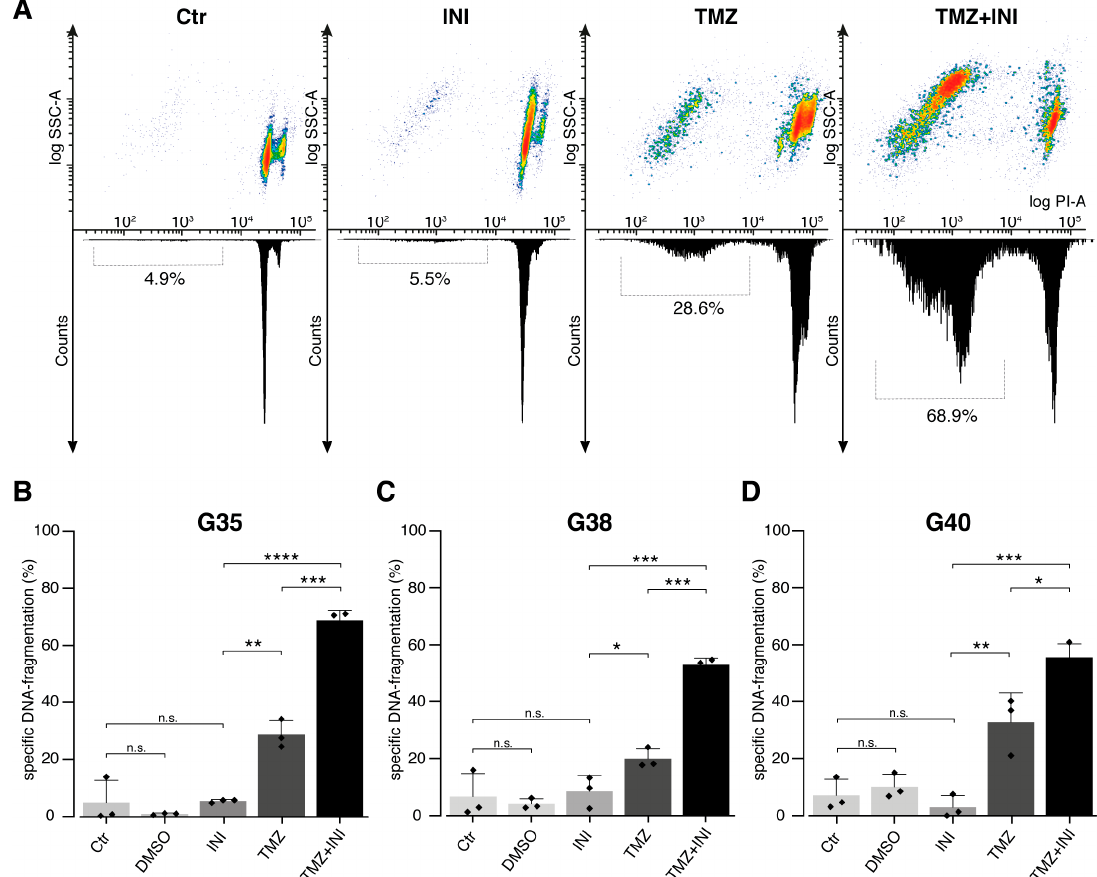
Figure 4. Gap junction-targeted therapy sensitizes glioblastoma cells to temozolomide-mediated cell death. ( A ) Effects on cell death: Treatment was performed with 50 µM TMZ, 100 µM INI, or combination of both. Percentage of DNA-fragmentation of propidium iodide-stained nuclei was determined by flow cytometric analysis 144 h after treatment. Representative density plots and histograms are shown for di ff erent treatment modalities for G35 cell population. The SubG1 peak is accentuated within the histograms and the mean percentage of DNA-fragmentation is depicted below. ( B ) Mean ± SD of specific DNA-fragmentation is shown for G35 ( B ), G38 ( C ), and G40 ( D ) primary glioblastoma cell populations. For each cell population three independent experiments were performed in